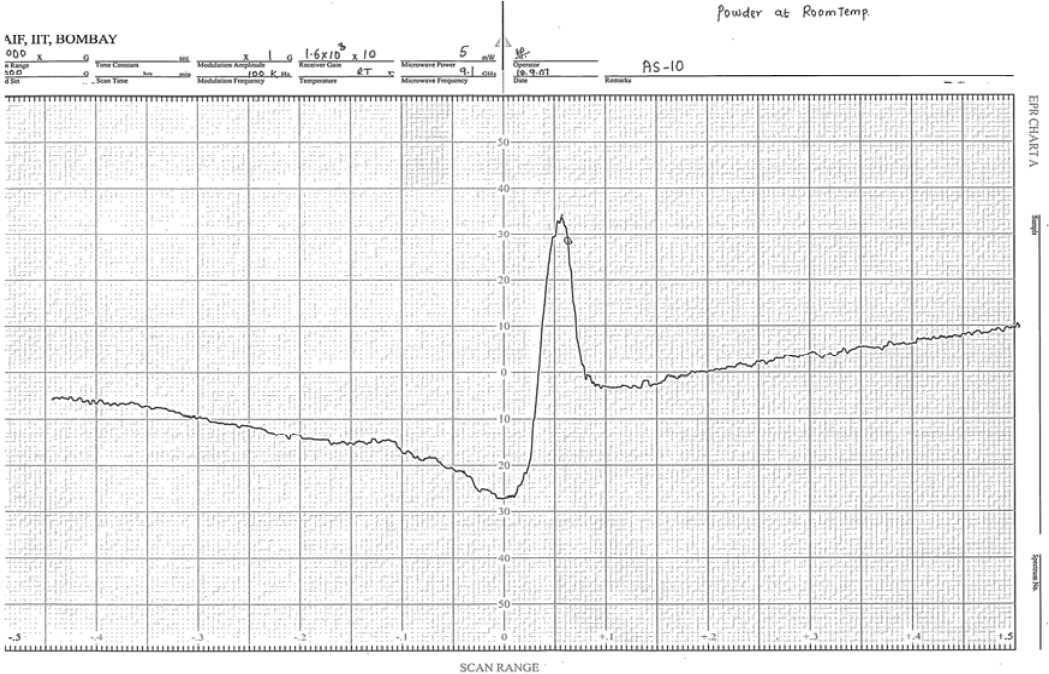
Figure 4. EPR spectrum of the [Cu(L)Cl]Cl